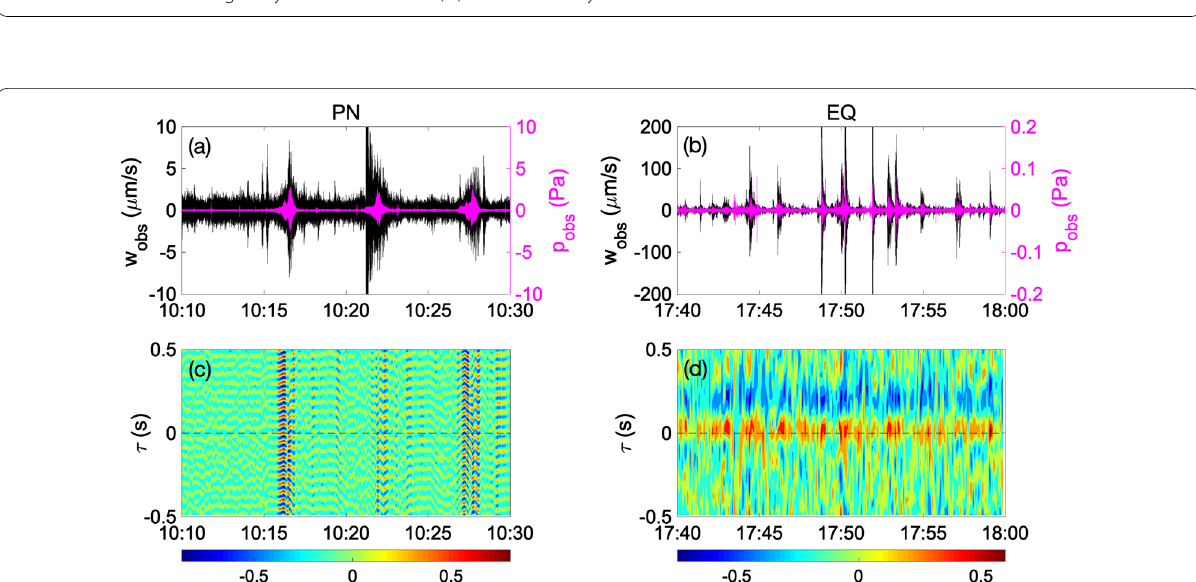
Fig. 5 a , b PN and EQ waveforms recorded at IOCD on September 12 and 18, 2018, respectively. The black shows the vertical component of the seismometer, and the magenta shows the microphone record. PN and EQ data are filtered within the frequency band of 10–30 Hz and 1–10 Hz, respectively. c , d The cross-correlation of the seismic and infrasonic data in a , b in a 5-s time window sliding every 1 s. The vertical axis, τ , is the